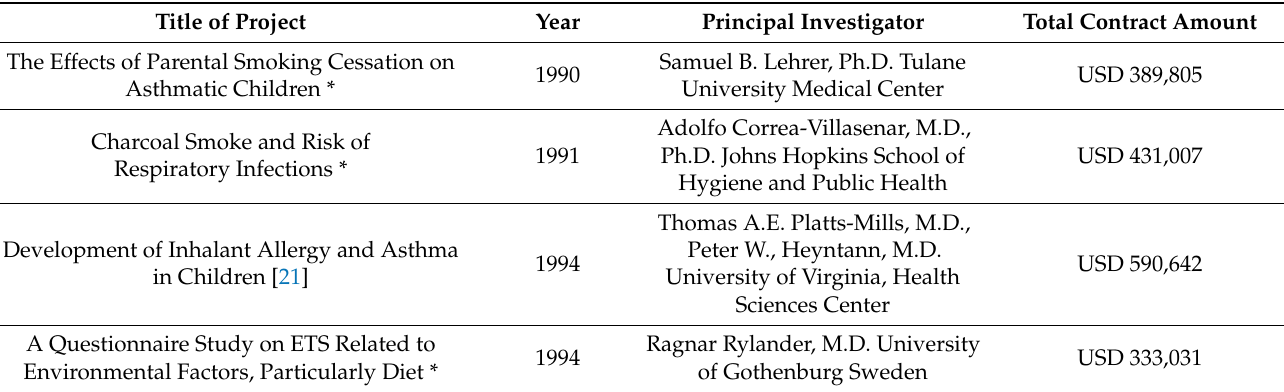
Table 1. Center for Indoor Air and Research Funded Projects on SHS in the